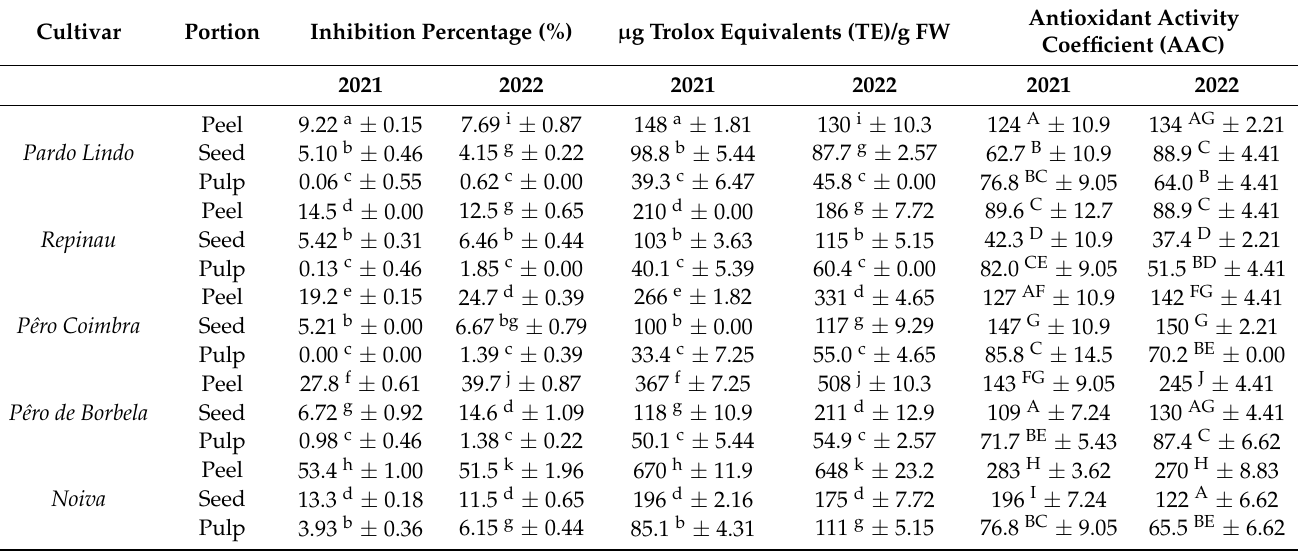
Antioxidant capacity of different portions of apple cultivars using two methods: DPPH radical scavenging assay and the β -carotene bleaching assay. Results are expressed as means ± standard